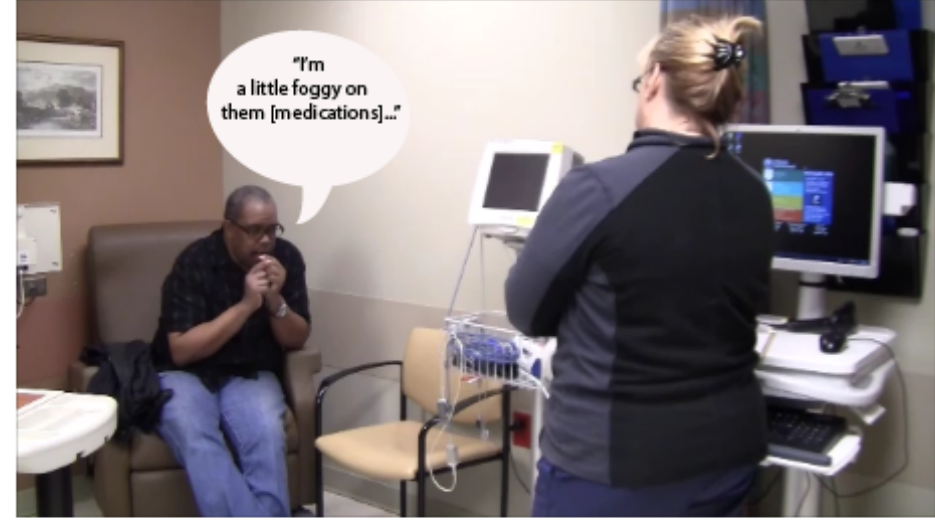
Figure 4. The patient attempts to recall from memory the details of specific medications during the medication reconciliation task.